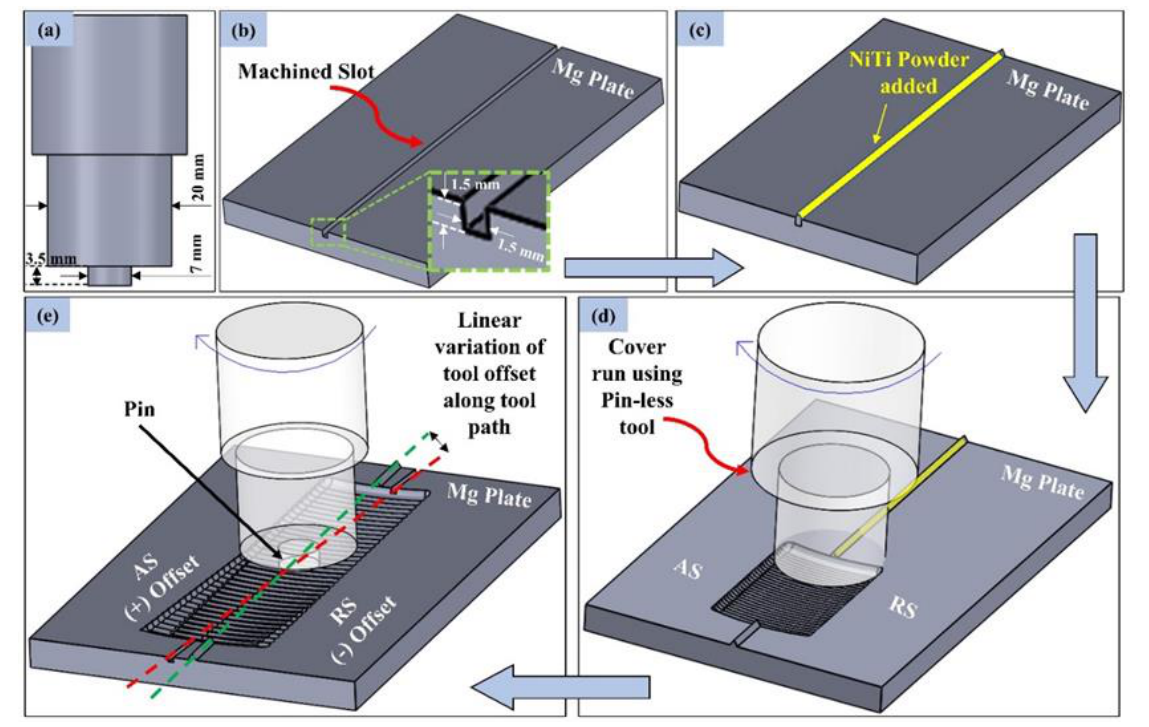
Figure 2. ( a ) Schematic representation of FSP tool, ( b ) Milled square slot of side 1.5 mm in the Mg plate, ( c ) Milled Mg plate packed with NiTi powder, ( d ) Cover run on the packed NiTi powder using pin-less tool, ( e ) FSP of the covered workpiece with a linearly varying offset.